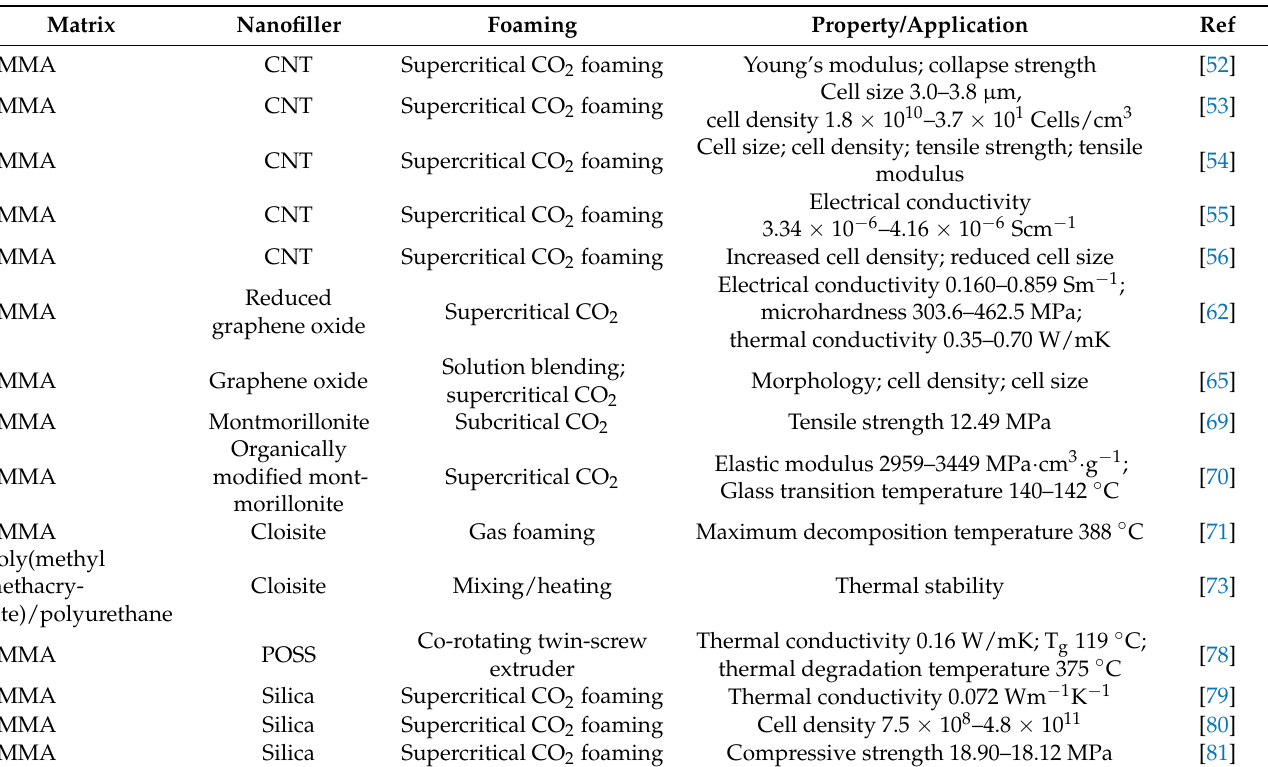
Table 3. Specifications of PMMA nanocomposite